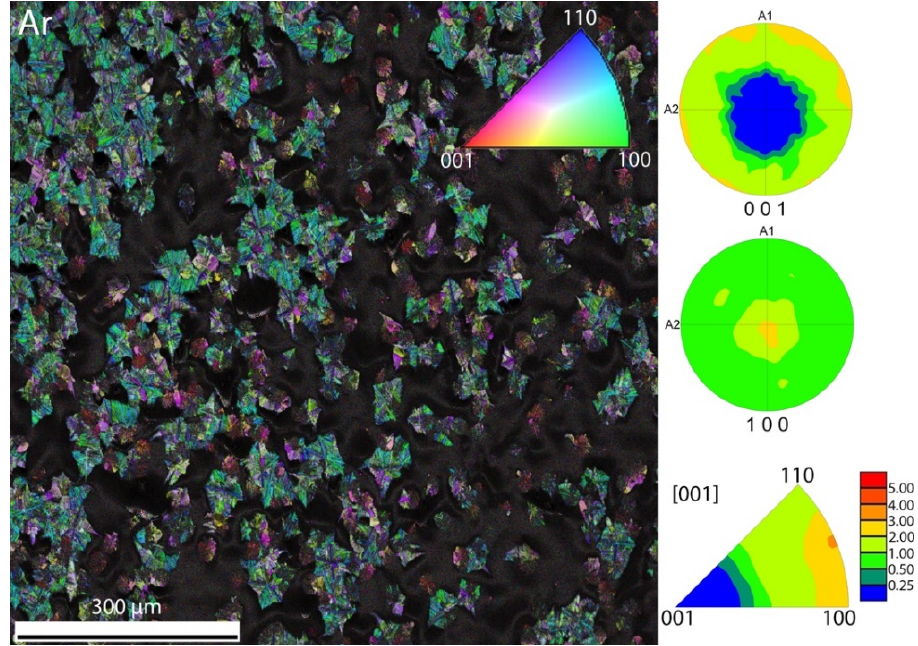
Figure 8. Texture and orientation data of a sample heat-treated in argon for 225 min. Left: 001 inverse pole figure mapping. Right circles: 001 and 100 pole figures, Bottom right: [001] inverse pole figure.